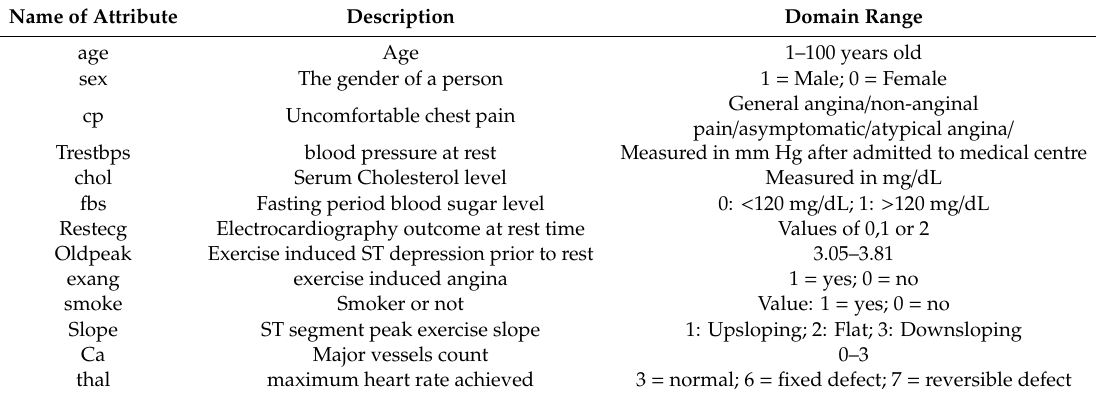
Table 5. Heart Disease dataset details